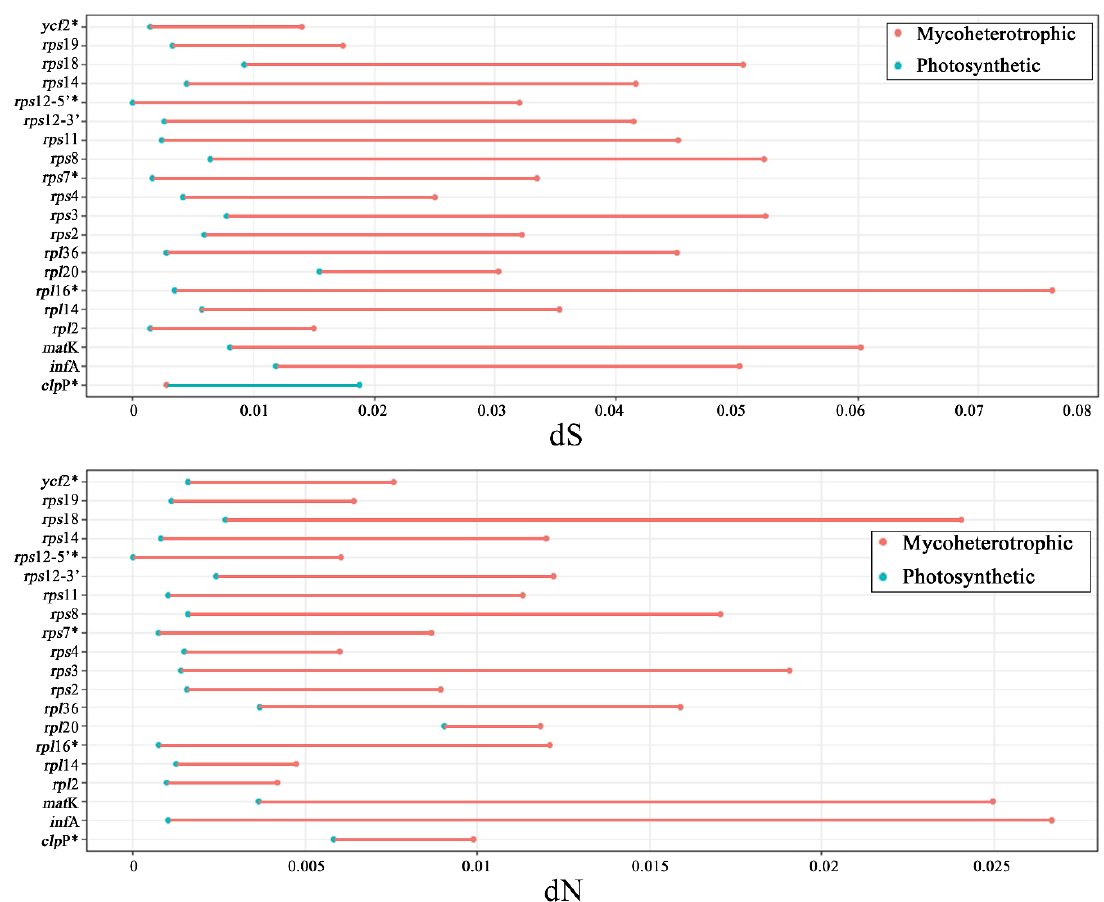
Figure 5. Comparison of synonymous/nonsynonymous substitution rates between mycoheterotrophic species and their photosynthetic relatives in the 20 commonly remaining protein-coding gene or gene regions. A region with a significant p -value ( p -value < 0.05) is tagged by an asterisk (*). Red line indicates an acceleration of the substitution rates; blue line indicates a deceleration of the substitution rates.